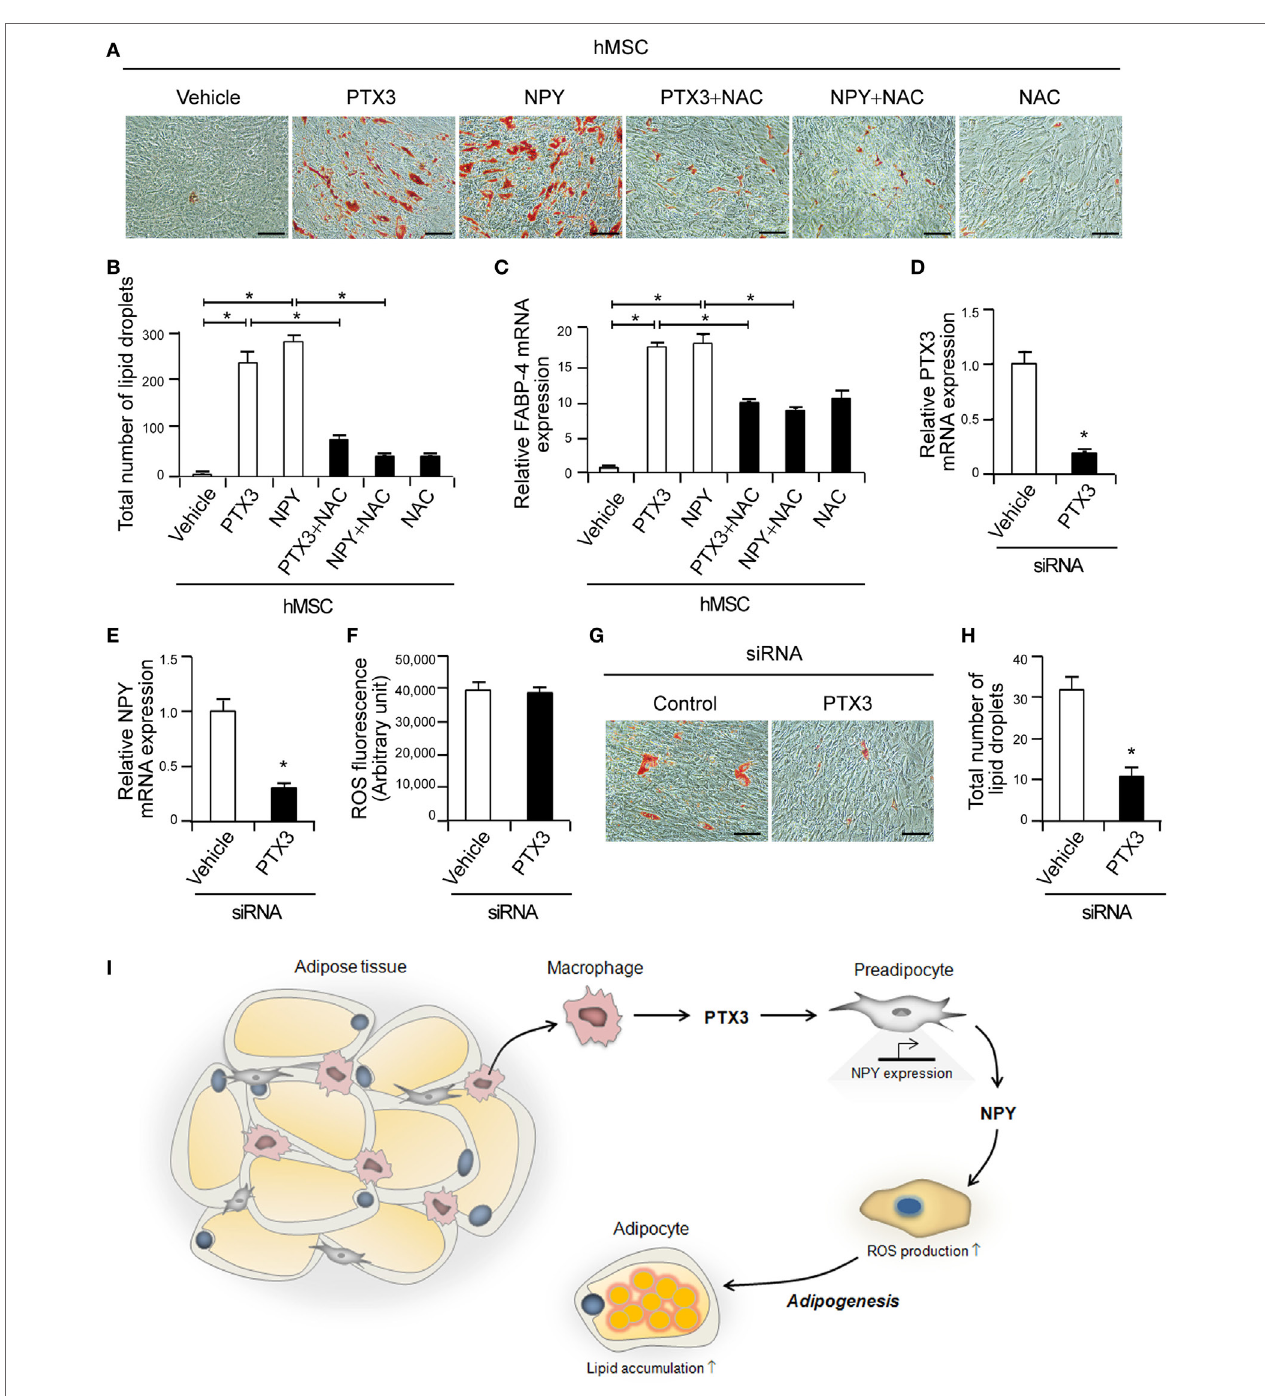
FigUre 6 | Pentraxin 3 (PTX3) and neuropeptide Y (NPY) induce adipogenesis in human mesenchymal stem cells (hMSCs). (a) Antioxidants prevent PTX3- or NPY-mediated increases in lipid accumulation in hMSCs. Oil-Red-O staining of hMSC cells treated with PTX3 or NPY with or without N -acetylcysteine (NAC) (10 mM) is shown. Scale bar: 100 microm (µM). (B) Quantification of the total number of lipid droplets in (a) ( n = 5). (c) The antioxidant NAC inhibits PTX3- and NPY-mediated increases in fatty acid binding protein-4 expression, as determined by quantitative real-time PCR (qPCR) ( n = 4). (D) hMSCs were transfected with either control or PTX3 targeting small interfering RNA (siRNA) and the silencing efficacy of PTX3 targeting siRNA was confirmed with qPCR ( n = 4). (e) NPY mRNA expression level in the cells shown in (D) was determined using qPCR ( n = 4). (F) Reactive oxygen species (ROS) levels were analyzed in hMSCs transfected with either control or PTX3 targeting siRNA ( n = 4). (g) Oil-Red-O staining of hMSCs transfected with siRNAs is shown. Scale bar: 100 microm (µM). (h) The total number of lipid droplets in (g) was quantified ( n = 5). Data are representative of more than two independent experiments. * p < 0.05 compared with the vehicle control. p values were calculated using Kruskal–Wallis test (B,c) or Mann–Whitney test (D–F,h) . Data values represent the mean ± SD. (i) Proposed mechanism of PTX3-induced adipogenesis. PTX3 promotes NPY expression and in turn NPY induces ROS production in adipocytes and adipogenesis. Consequently, PTX3 enhances adipocyte differentiation and subsequent lipid accumulation in adipocytes via NPY/NPYR